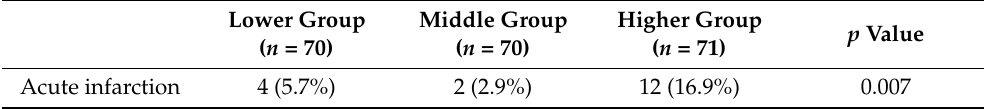
Table 2. Incidence rates of acute